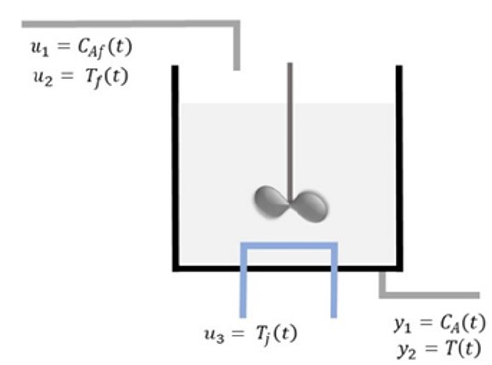
Figure 14. CSTR process